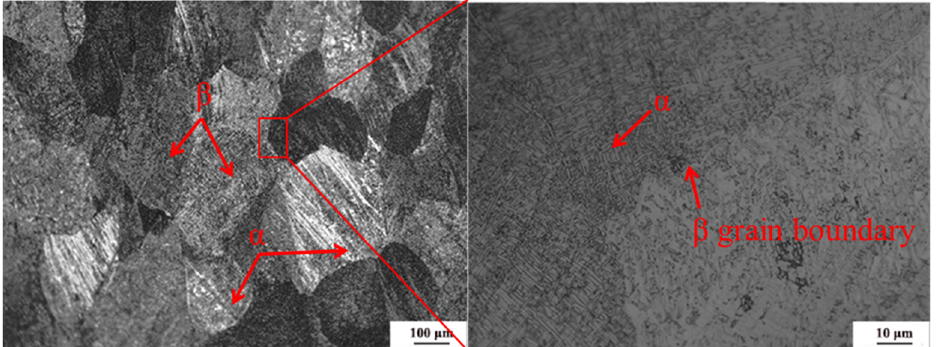
Figure 2: Original microstructures for TB6 alloy.